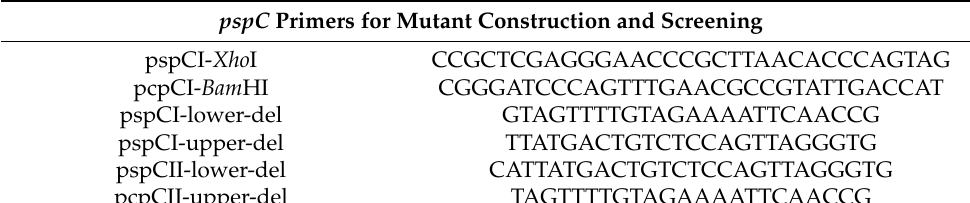
Table 1. Primers used for generation of ∆ psp mutants of Y. pestis . pspC Primers for Mutant Construction and